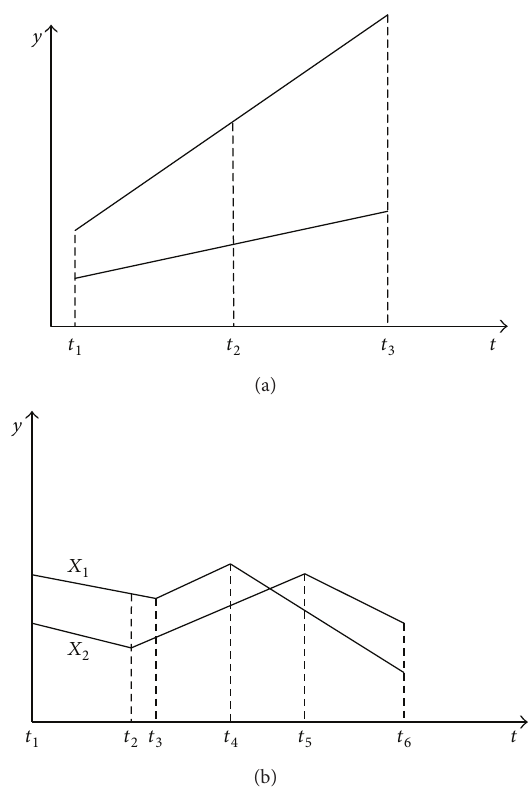
Figure 3: Diagrams of (a) “linear-type” time series and (b) “time- dislocation-type” time